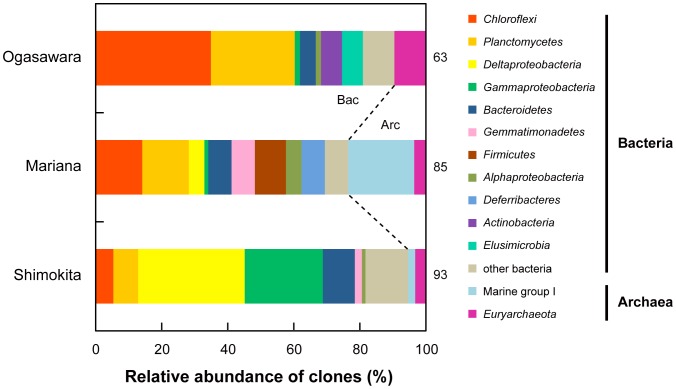
Prokaryotic community structures based on the bacterial and archaeal 16S rRNA gene clone sequences detected from the deep-sea shallow subseafloor sediments from the Ogasawara, Mariana, and Shimokita locations.The numbers on the right of each row show the numbers of the sequenced clones in each library. The “Others” category represents the bacterial taxa that compose less than 5% of the total clone numbers.